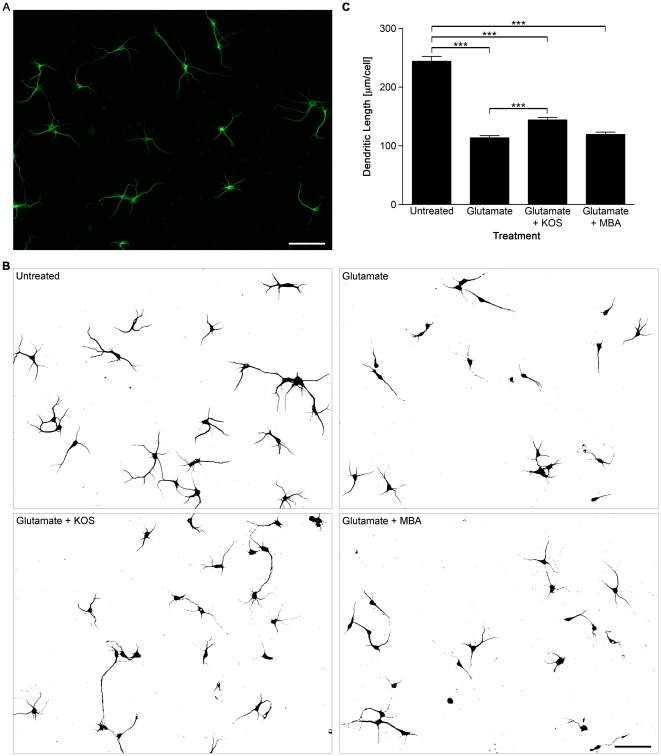
Koshu GSE protects dendrite processing of cultured hippocampal neurons exposed to a toxic concentration of glutamate.(A) Representative image of untreated hippocampal neurons at 8 DIV immunostained for MAP2. Bar, 100 µm. (B) Representative binary images of cultured hippocampal neurons immunostained for MAP2 with no treatment or after a 30 min treatment with 50 µM glutamate alone, 50 µM glutamate plus 1.0 ng/ml KOS, or 50 µM glutamate plus 1.0 ng/ml MBA. Bar, 100 µm. (C) Quantification of the mean dendrite length by morphometric analysis (n = 10). ***, P<0.001 versus untreated controls.